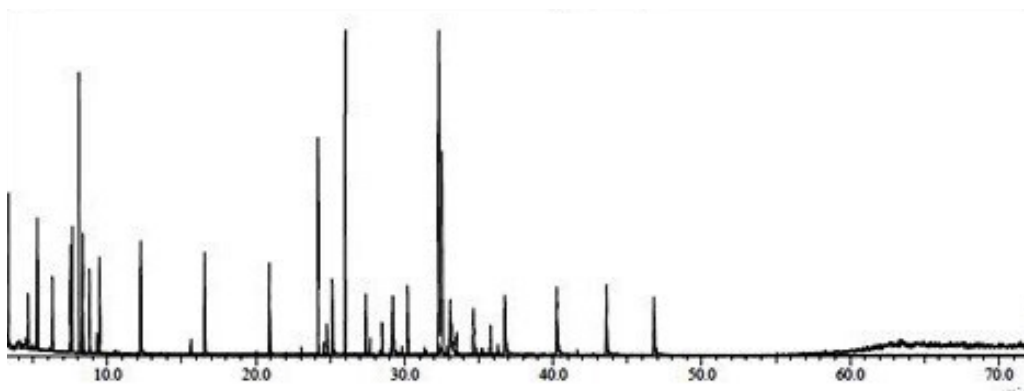
Figure 2 - GC-MS chromatogram of the essential oil from P. ovatum